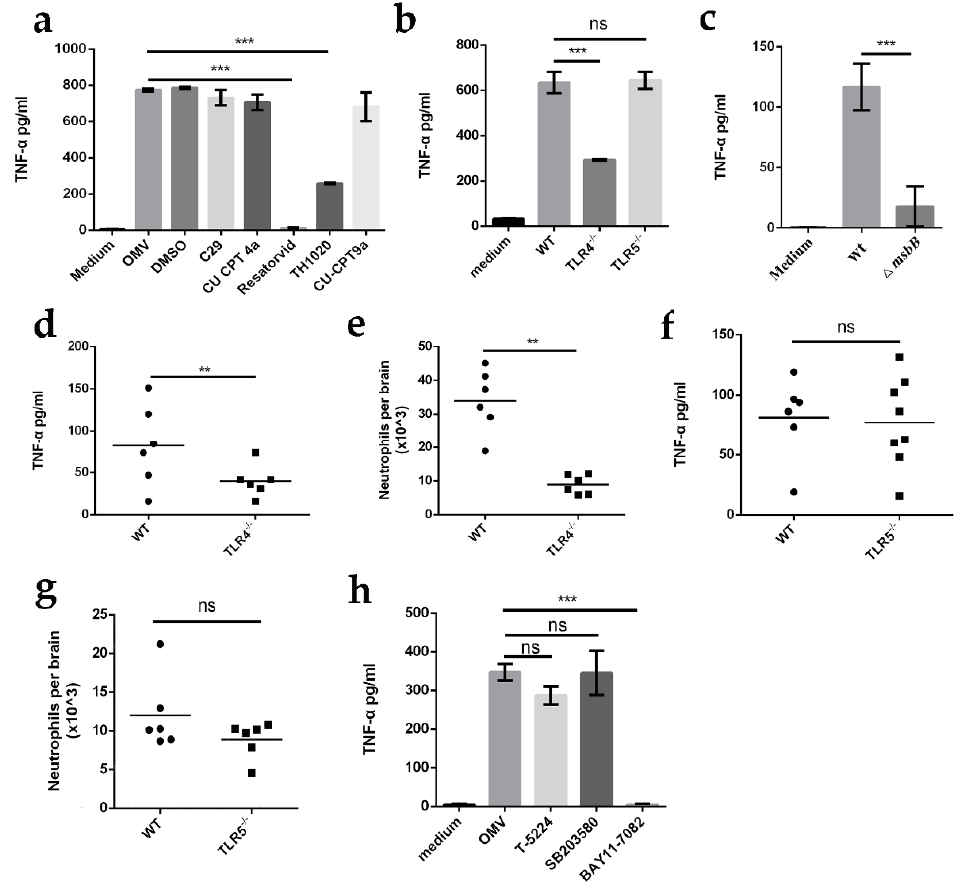
Figure 4. Microglia TLR4 recognizes LPS of the E.-coli -K1-derived OMV to release TNF- α . ( a ) ELISA of TNF- α protein levels in BV2 microglial cell line incubated with E.-coli -K1-derived OMVs for 2 h in the presence of TLR2 inhibitor C29, TLR3 inhibitor CU CPT4a, TLR4 inhibitor Resatorvid, TLR5 inhibitor TH1020, or TLR8 inhibitor CU-CPT9a. ( b ) ELISA of TNF- α protein levels in primary microglia derived from wild-type mice (WT), TLR4 deficient mice ( TLR4 − / − ), and TLR5 deficient mice ( TLR5 − / − ) after incubation with E.-coli -K1-derived OMVs for 2 h. ( c ) ELISA analysis of TNF- α protein levels in primary microglia that were incubated with E. coli- K1-wild-type- (wt) or Δ msbB -derived OMVs for 2 h. ( d – g ) TLR4 or TLR5 deficient mice were infected wild-type with E. coli K1 for 12 h. Thereafter, the TNF- α protein levels ( d , f ; n = 6 mice per group) and neutrophil counts ( e , g ; n = 6 mice per group) in the mouse brain were analyzed. ( h ) ELISA analysis of TNF- α protein levels in primary microglia that were pretreated with BAY11-7082 (NF- κ B inhibitor), T-5224 (c-Fos/AP-1 inhibitor), or SB203580 (p38 MAPK inhibitor) for 2 h, and then incubated with E.-coli -K1-derived OMVs for 2 h. Data are presented as mean ± SD, n = 3 independent experiments ( a – c , h ). p values were determined using Student’s t -test ( a – c , h ) or Mann–Whitney U test ( d – g ). ** p < 0.01; *** p < 0.001; ns, not significant.